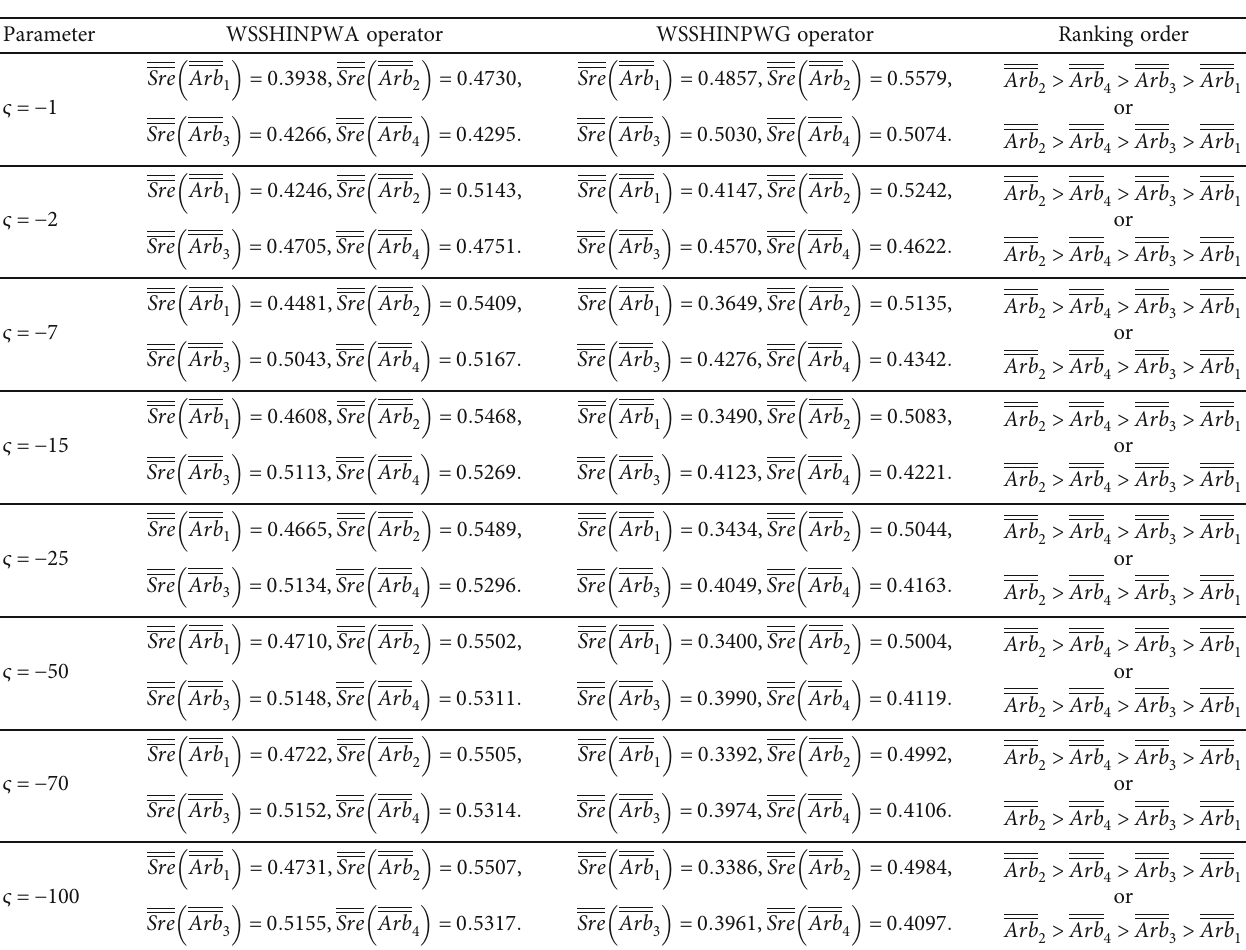
Table 3: E ff ect of the parameter ς on fi nal ranking order.